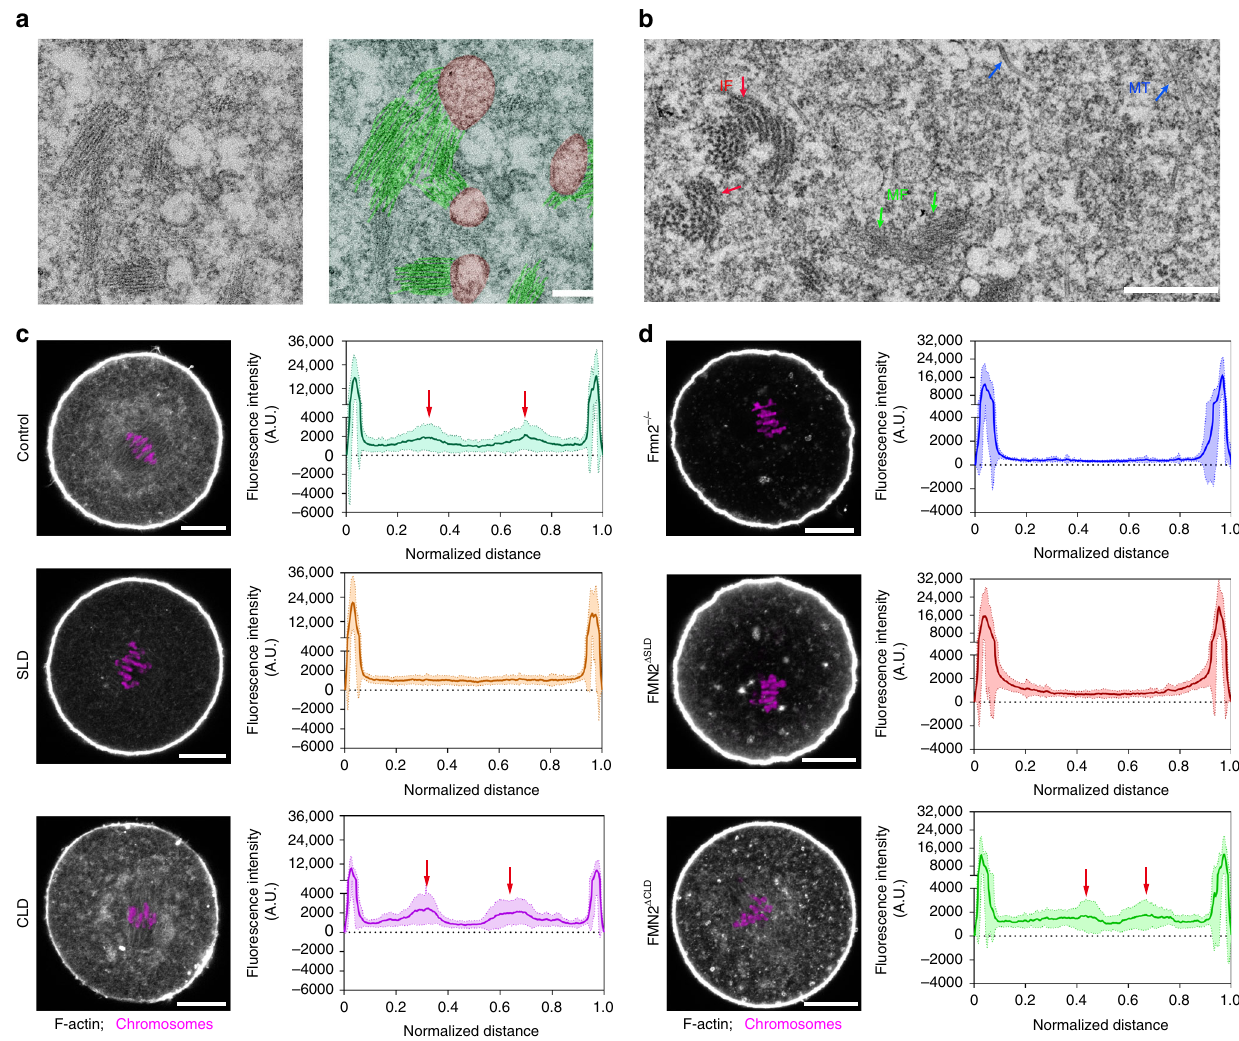
Fig. 2 Spindle peripheral FMN2 is required for actin polymerization surrounding the spindle. a Representative EM images of MI oocytes show that short bundles of actin fi laments form comet tail-like end-on association with the surface of ER-like vesicles. Red, ER-like vesicles. Green, F-actin bundles. Representative results, n = 3. Scale bar, 0.2 µ m. b Representative EM images of MI oocytes show different appearance and thickness of micro fi lament (MF, green arrow), intermediate fi lament (IF, red arrow) or microtubule (MT, blue arrow). Representative results, n = 3. Scale bar, 0.5 µ m. c Representative images of rhodamine phalloidin staining of F-actin after SLD or CLD expression in wild-type oocytes. The accumulation of F-actin surrounding the spindle was disrupted in oocytes expressing SLD but not CLD. The curves show the average of fl uorescence intensity trace of actin along a thick line crossing the mid-zone of the MI spindle and the shades show the SD of the central lines (see Supplementary Fig. 1c). Red arrows point to actin intensity peaks around the spindle. n = 21 (control), n = 13 (CLD), n = 21 (SLD). Scale bar, 20 µ m. d Representative images of phalloidin staining in Fmn2 − / − oocytes with FMN2 Δ SLD or FMN2 Δ CLD expression. FMN2 Δ CLD rescued the spindle peripheral F-actin accumulation in Fmn2 − / − oocytes. Line traces of average fl uorescence intensity of actin and SD (shade) are shown as in c . n = 19 (Fmn2 − / − ), n = 15 (FMN2 Δ CLD ), n = 17 (FMN2 Δ SLD ). Scale bar, 20 µ